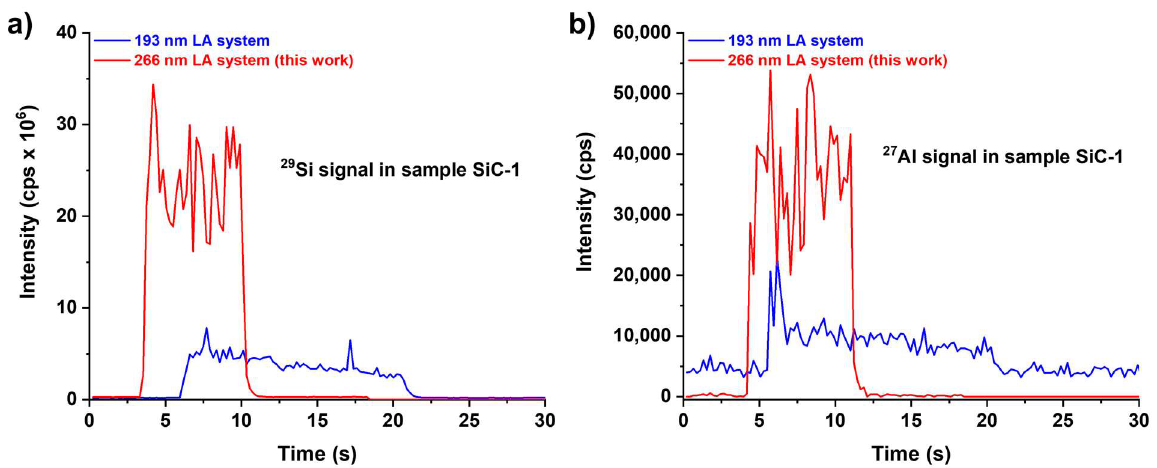
Figure 7. Signal profiles of ( a ) 29 Si and ( b ) 27 Al acquired by using an excimer-based 193 nm (blue lines) and a Nd:YAG-based 266 nm (red lines) LA-ICP-MS instrumentation.